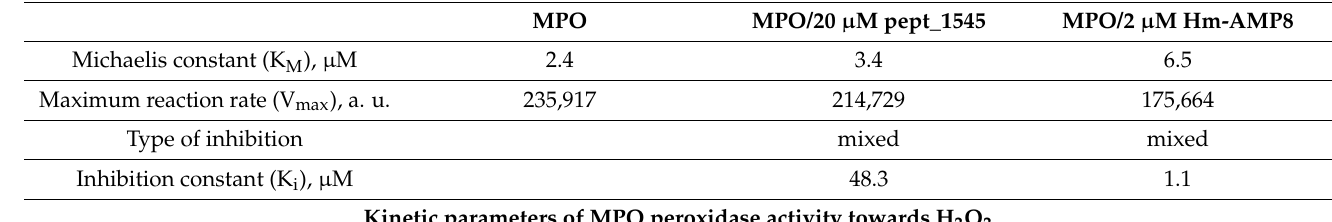
Table 3. Pept_1545 and Hm-AMP8 inhibit MPO. Kinetic parameters for MPO peroxidase activity towards Amplex Red (upper panel) and H 2 O 2 (lower panel), as measured by Amplex Red oxidation by MPO (8 nM heme) in the absence and presence of the peptides in 50 mM K-phosphate buffer, pH 7.4. The data presented were obtained using the Hanes–Woolf linearizations for different Amplex Red concentrations with 25 µ M H 2 O 2 and for different H 2 O 2 concentrations with 50 µ M Amplex Red. Kinetic Parameters of MPO Peroxidase Activity towards Amplex Red MPO MPO/20 µ M pept_1545 MPO/2 µ M